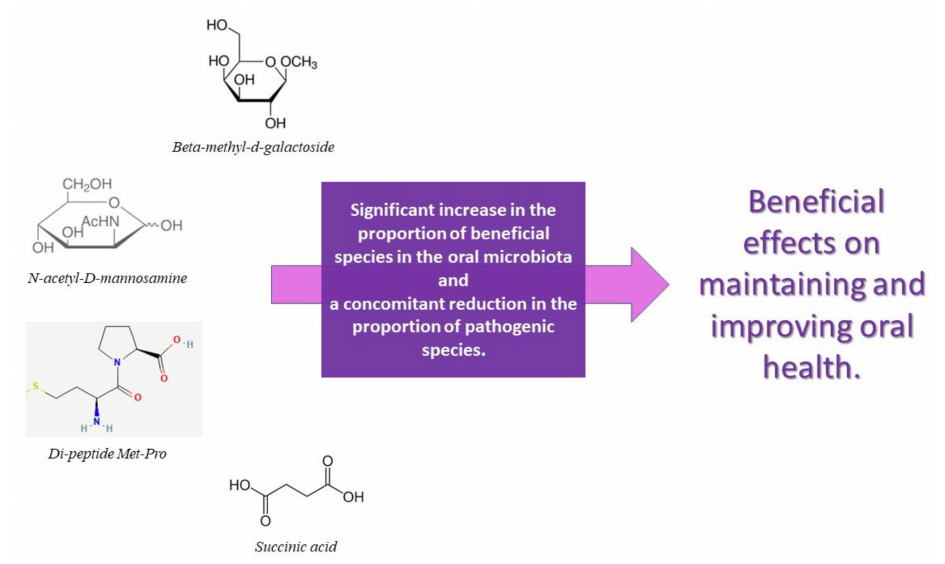
Figure 5. List and action of the main prebiotics that confer oral health